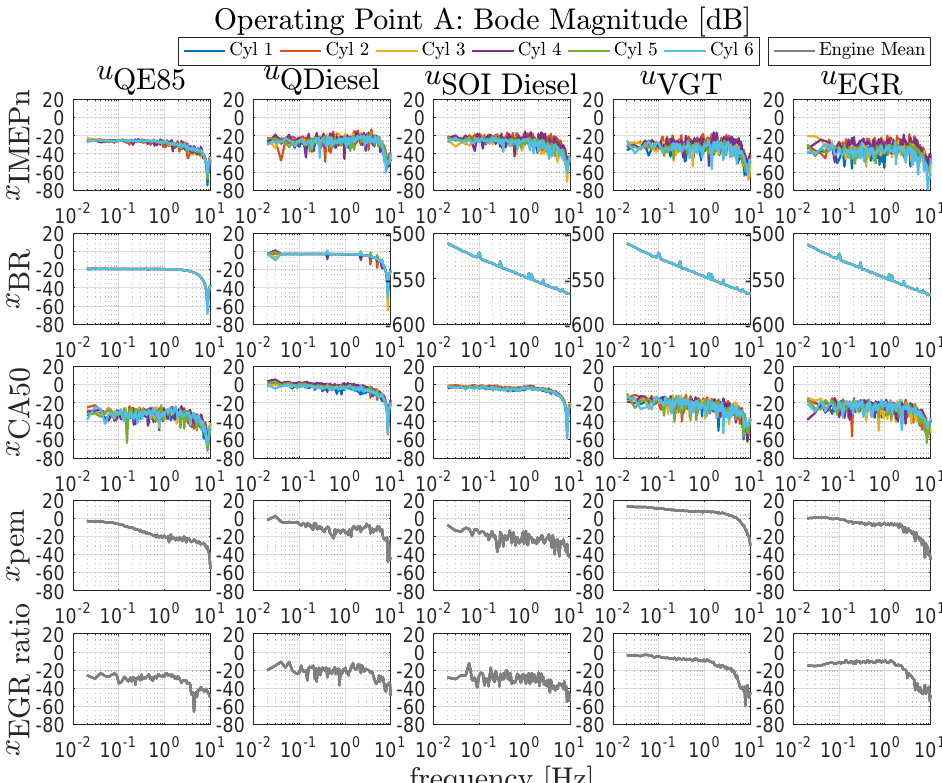
Figure 4. MIMO system identification results for operating point A. Reprinted from [19] with permission of the International Federation of Automatic Control